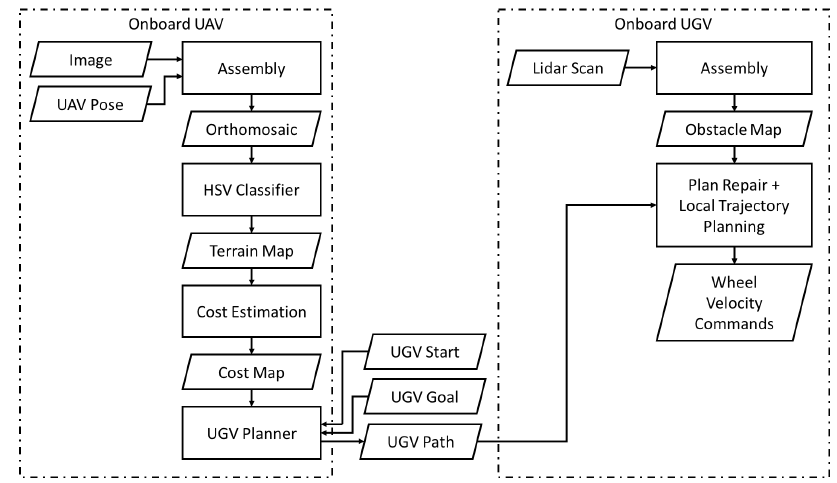
Figure 5. Flow chart displaying the mapping, path planning, and path execution pipelines running onboard the UAVs and UGVs. HSV: Hue Saturation